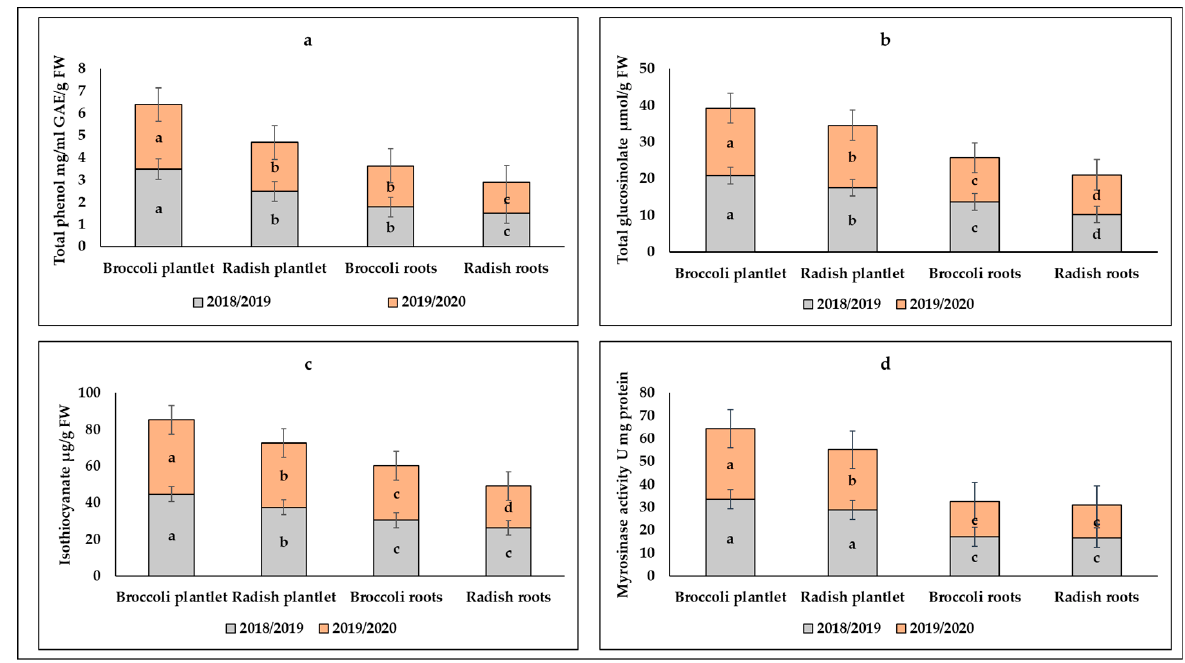
Figure 8. The concentrations of total phenol, total glucosinolates, isothiocyanates, and myrosinase activity contents according to various treatments in two seasons 2018/2019 and 2019/2020. (( a ) total phenol, ( b ) total glucosinolates, ( c ) isothiocyanates, and ( d ) myrosinase activity contents). Means (±SE) followed by the same letter are not significantly different at p ≤ 0.05 (LSD test).